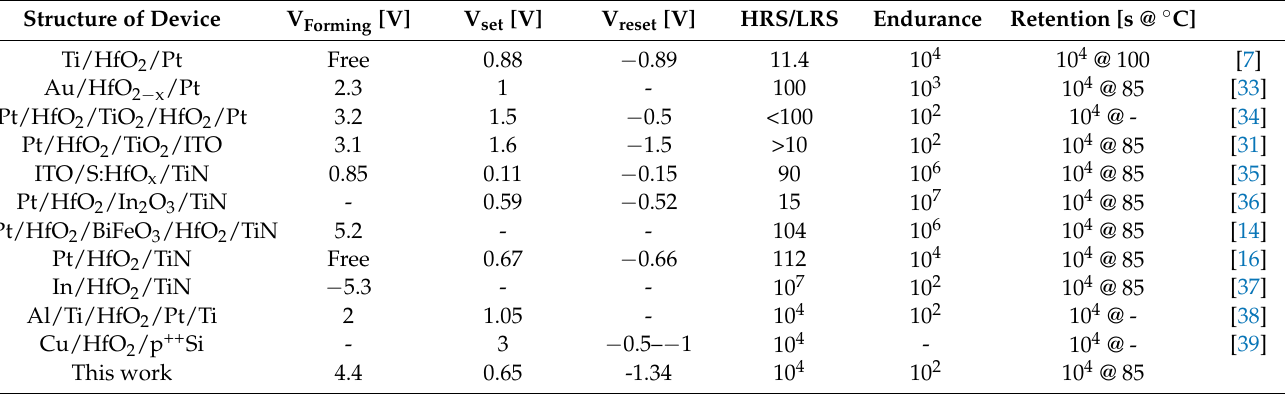
Figure 4. ( a ) I – V characteristics of Au/HfO 2 /Al-ZnO/HfO 2 /ITO device at operating voltage ( − 5 – 5 V); ( b ) 100 cycles of high-/low-resistance state resistance distribution, read at 0.25 V; ( c ) cumulative distribution of HRS and LRS; and ( d ) retention of resistance states, read at 0.1 V. Table 1. Comparison of HfO 2 -based